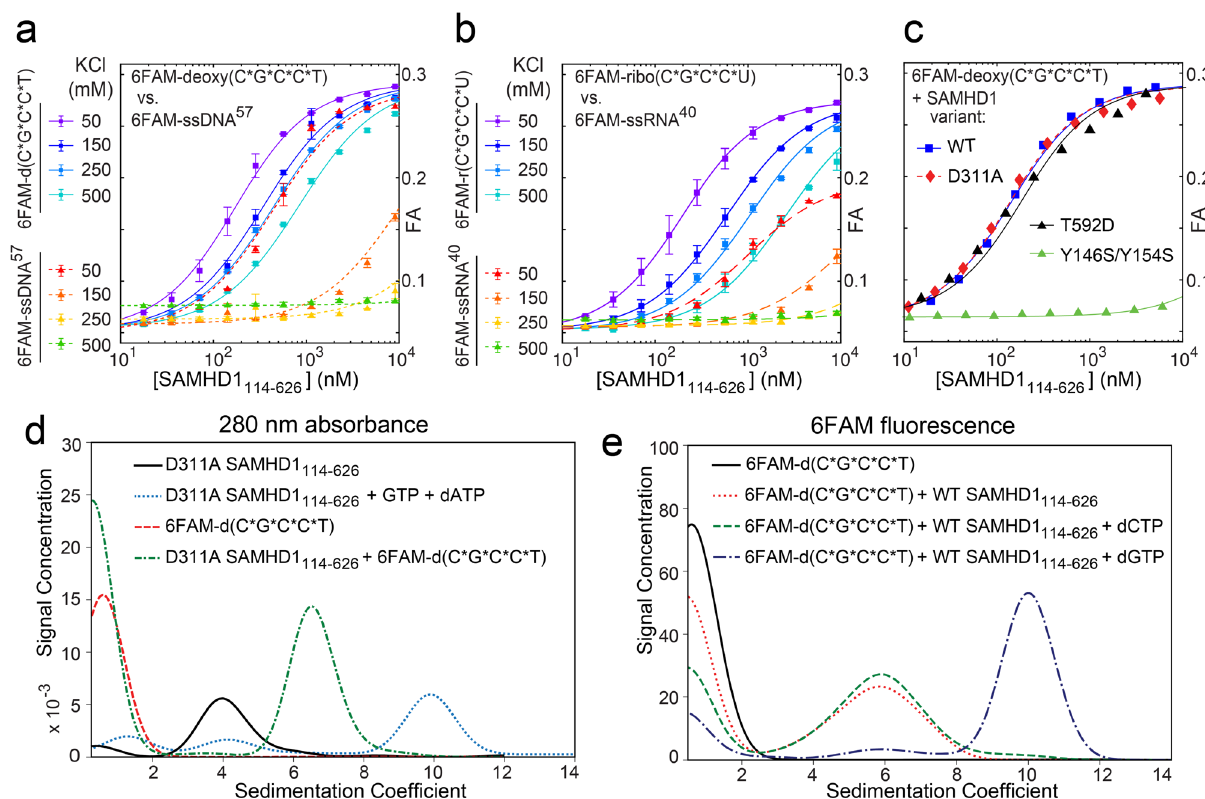
Fig. 1 Interaction of SAMHD1 with short phosphorothioated oligonucleotides. a , b Fluorescence anisotropy (FA)-binding assays reveal that binding of short phosphorothioated oligonucleotides to SAMHD1 is remarkably tolerant to increasing salt concentration compared to phosphodiester-linked (6FAM- ssDNA 57 and 6FAM-ssRNA 40 ) oligonucleotide binding 47 . Location of phosphorothioate bonds is denoted with asterisks in all fi gures ( n = 2 independent experiments). c Oligomerization-defective mutant Y146S/Y154S is impaired in oligonucleotide binding. d Analysis of SAMHD1 ligand-induced oligomerization by analytical ultracentrifugation (AUC) using 280-nm absorbance readout. e AUC analysis using 6FAM fl uorescence detection reveals association of oligonucleotides with SAMHD1 dimers and tetramers. Error bars represent s.d. of two replicate measurements performed on distinct samples. Source data are provided as a Source Data